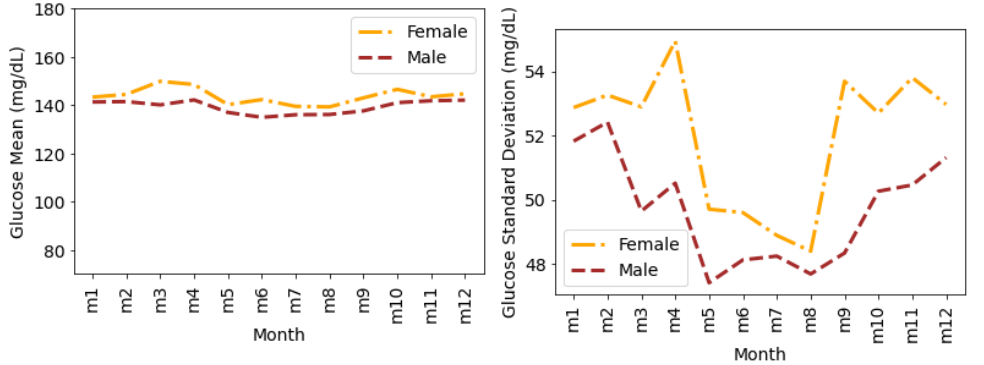
Figure 8. Average glucose mean and standard deviation for insulin-requiring individuals in OpenAPS Data Commons dataset during months of a year based on gender. Total number of males and females is 50 and 28, respectively. m1 represents January, m2 represents February, and similarly m12 represents December.